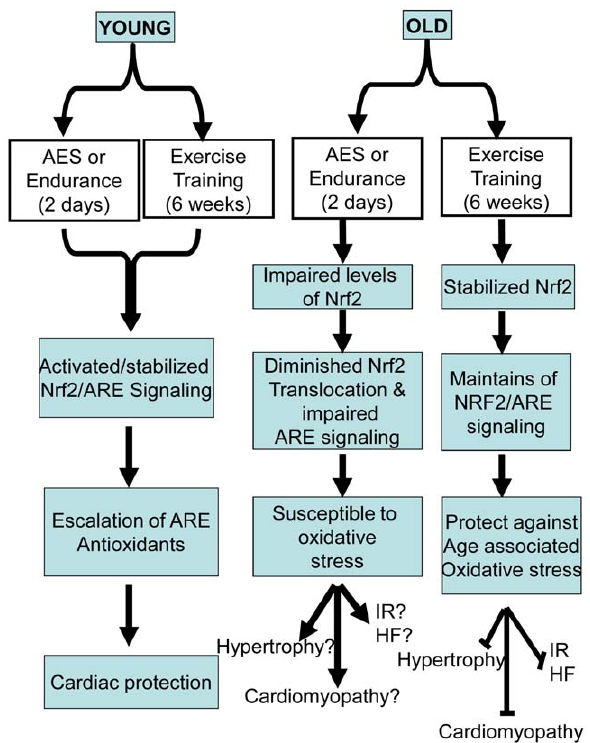
Figure 8. Proposed model for age-associated deregulation and exercise training mediated stabilization of Nrf2/ARE-signaling.